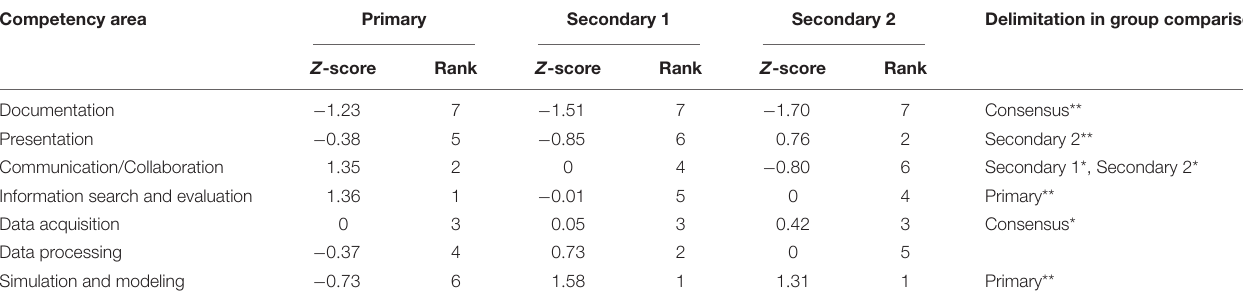
TABLE 2 | Factor scores with corresponding